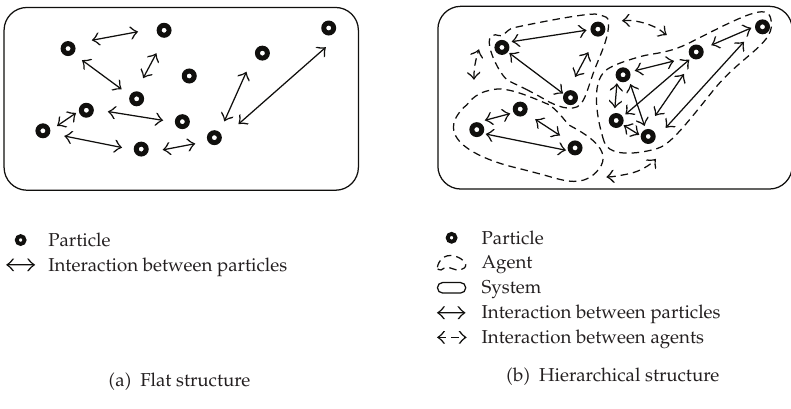
Figure 1: Two types of